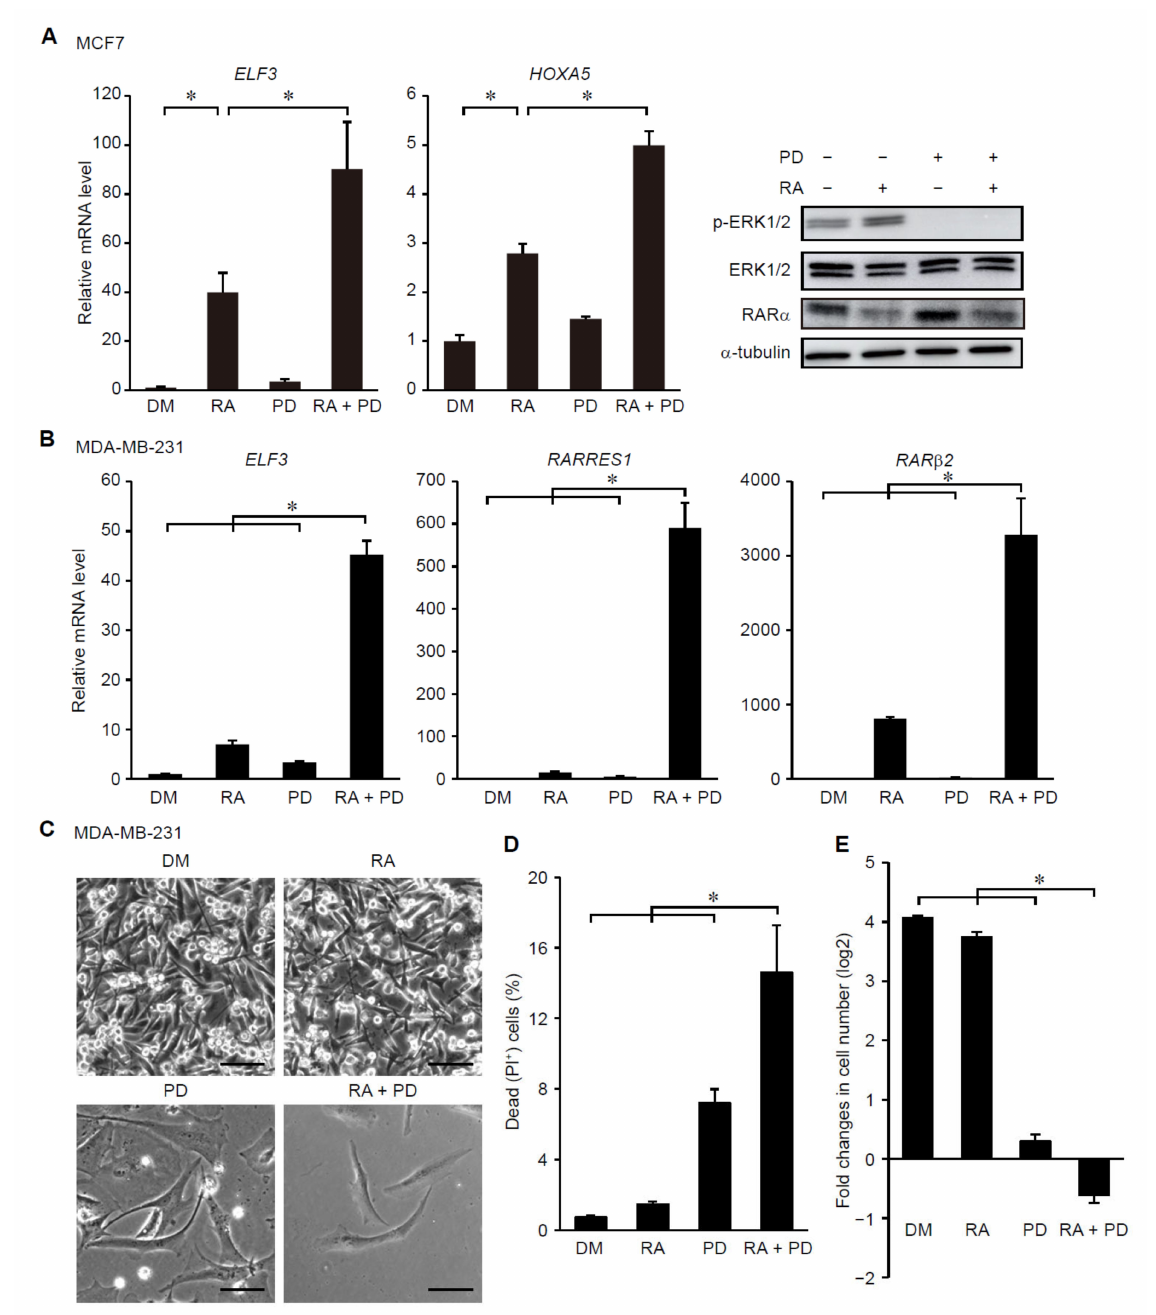
Figure 2. Inhibition of the ERK pathway potentiates RA-induced expression of RAR-target genes, growth suppression and cell death in breast cancer cells. ( A ) MCF7 cells were treated with RA (1 µ M), a MEK inhibitor (PD0325901, 3 µ M), and/or DMSO for 24 h. Total RNA and cell lysates were prepared and analyzed by RT-PCR (left) and immunoblotting (right), respectively. *, p < 0.05 (one-way ANOVA followed by Tukey post hoc analyses) (mean + s.e.m., n = 4). Uncropped immunoblot images are shown in Supplementary Material (Figure S1). ( B – E ) MDA-MB-231 cells were treated with RA (1 µ M), a MEK inhibitor (PD0325901, 3 µ M), and/or DMSO for 8 days ( B , C , E ) or 6 days ( D ). Total RNA was prepared and analyzed by RT-PCR (B). ( C ) Morphology of MDA-MB-231 cells treated with or without RA and a MEK inhibitor. Scale bars: 50 µ m. ( D ) Survival rates of MDA-MB-231 cells treated with or without RA and/or a MEK inhibitor. ( E ) Fold changes in cell number after 8 days culture in the absence or presence of RA and/or a MEK inhibitor. *, p < 0.05 (one-way ANOVA followed by Tukey post hoc analyses) (mean + s.e.m., n = 4 ( B , E ); n = 6 ( D